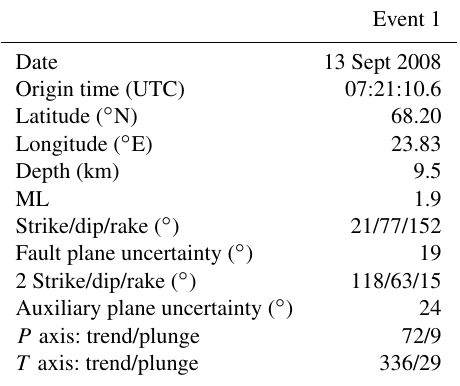
Table 4. Source parameters of the event considered in our study.